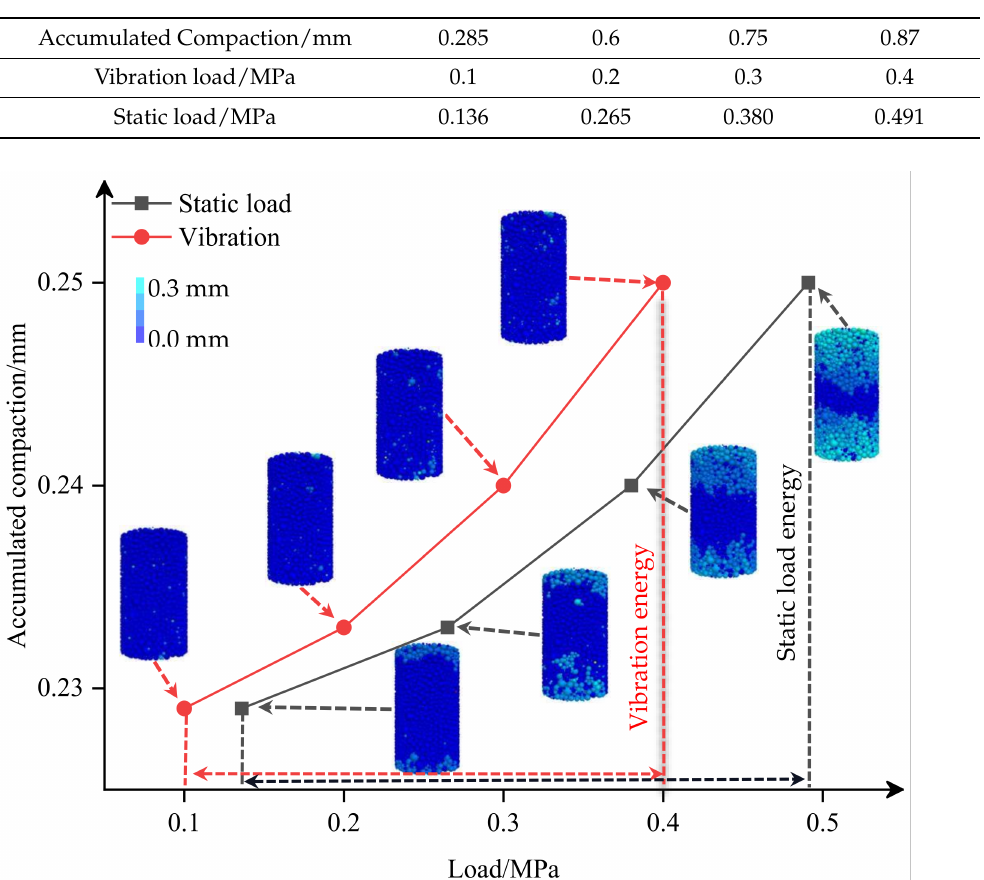
Table 3. The vibration and static loads required by the same cumulative compaction.